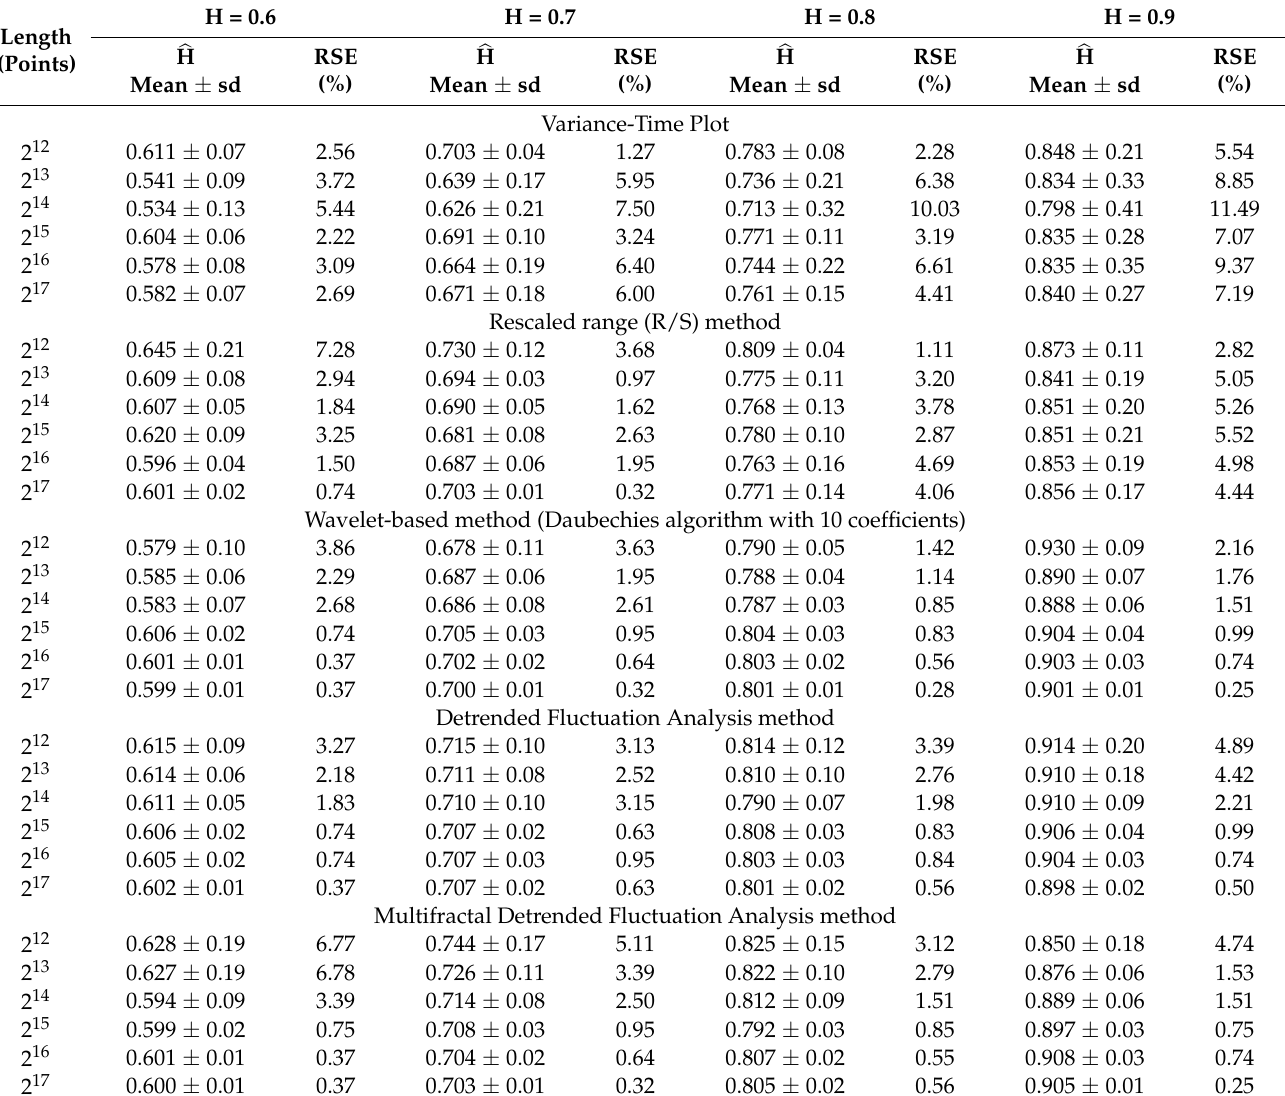
Table 1. Comparative analysis between five statistical methods in determining the Hurst exponent at different FGN fractal process